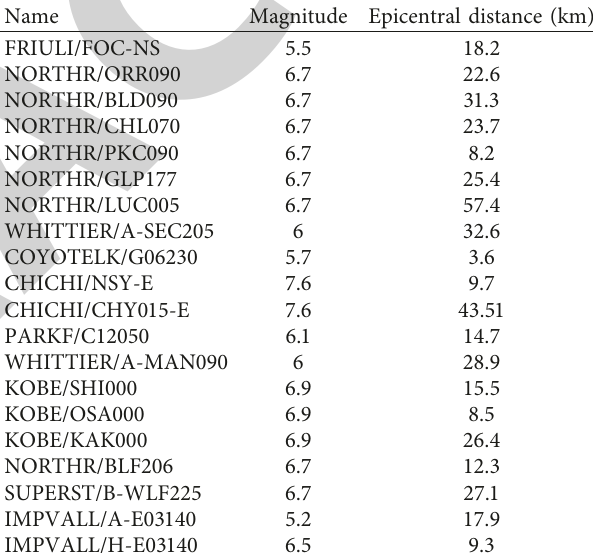
Figure 4: Three-dimensional FEM model. This figure is repro- duced from [25] (under the Creative Commons Attribution License/public domain). Table 1: Selected earthquake